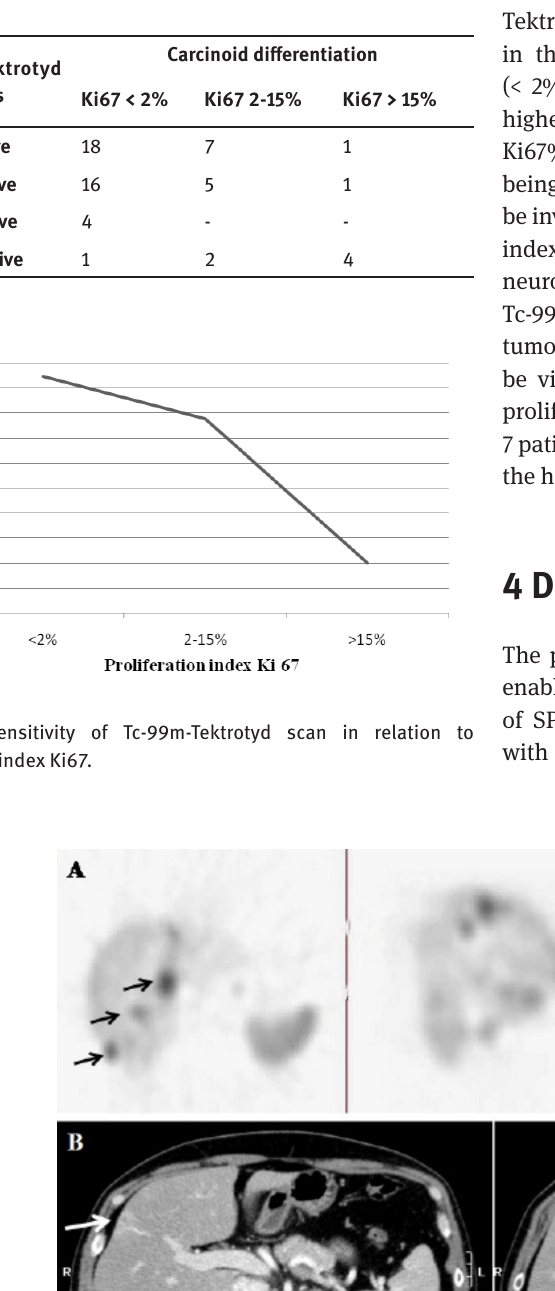
Table 3: Tc-99m-Tektrotyd scan results in relation to carcinoid differentiation.